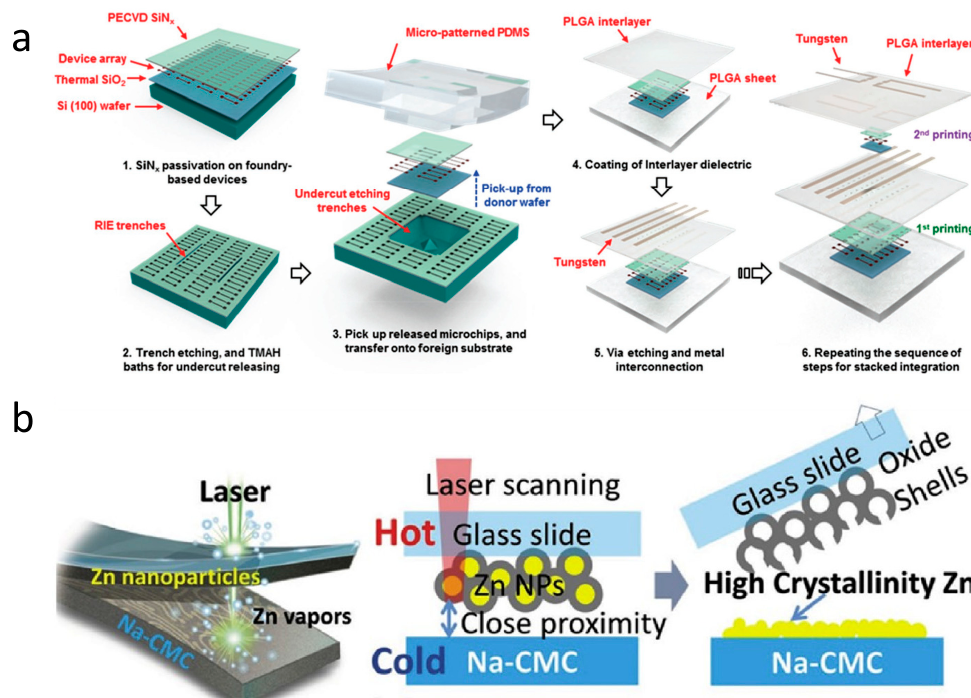
Figure 3. Fabrication schemes for soft and biodegradable electronics. ( a ) Preparation process of a 3D interconnected platform. Planarizing layers of PLGA serve as adhesives and interlayer dielectrics to facilitate 3D heterogeneous integration. ( b ) The schematic printing process for evaporation–condensation-mediated laser printing. Reproduced with permission from [21,86].